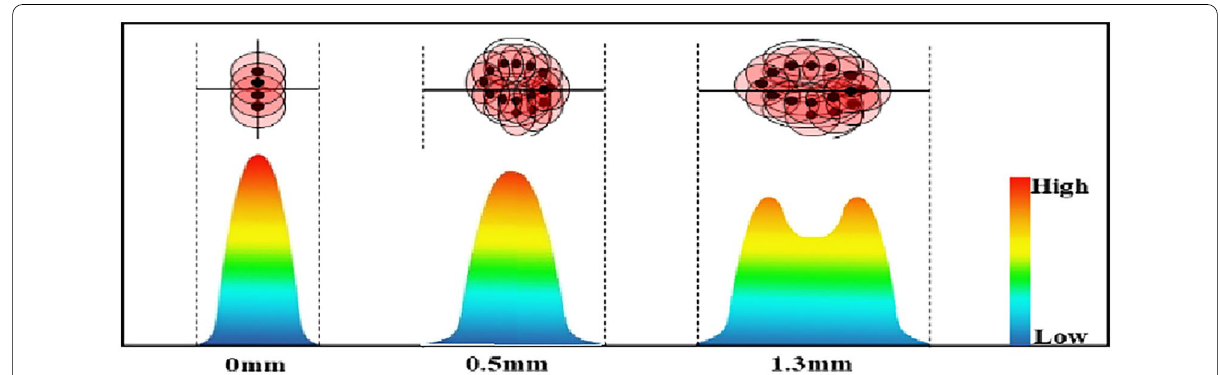
Figure 6 Schematic illustration of energy distribution